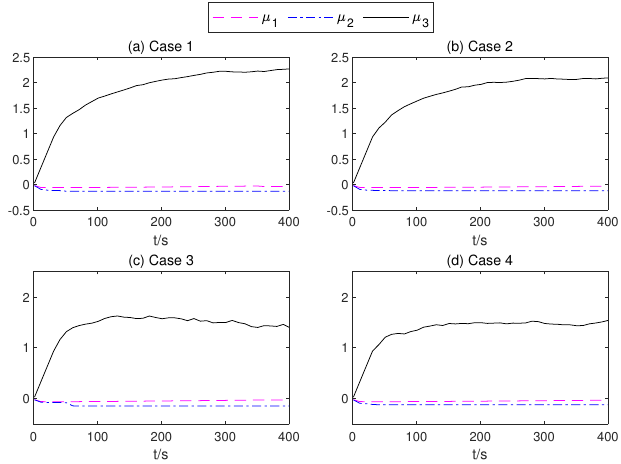
Figure 12. Weights of one of the fully connected layers of the critic Net.